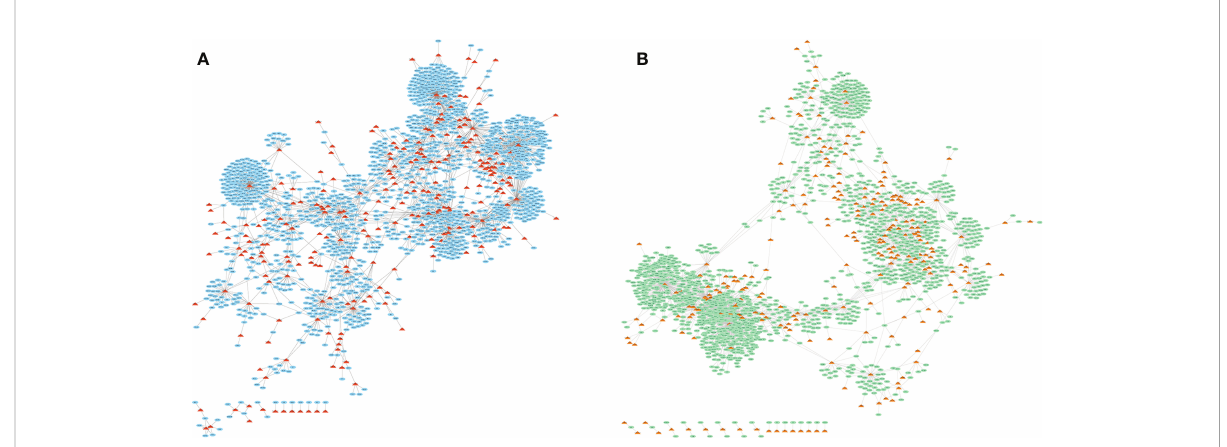
(Figure 2D). In the crosstalk network, two pathways are connected by an edge if they shared at least one gene. We found that PI3K-Akt signaling pathway is enriched by mRNAs on both ceRNA networks. Insulin-activated IRS/PI3K/PKB pathway cascade cross talk could reduce glucose production (20).